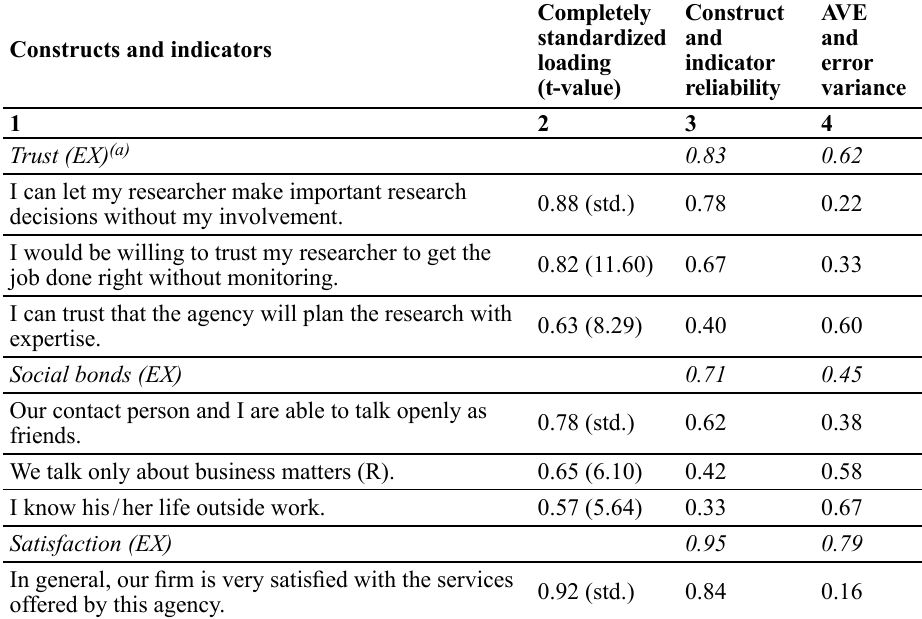
Table 2. Overall CFA for the modified measurement model based on the RM approach (n = 150)